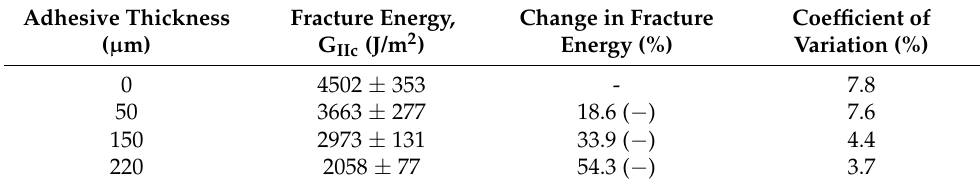
Figure 17. Variation of fracture energy with interleaving film thickness in Mode II. Table 4. Effect of interleaving film thickness on the fracture energy in Mode II.